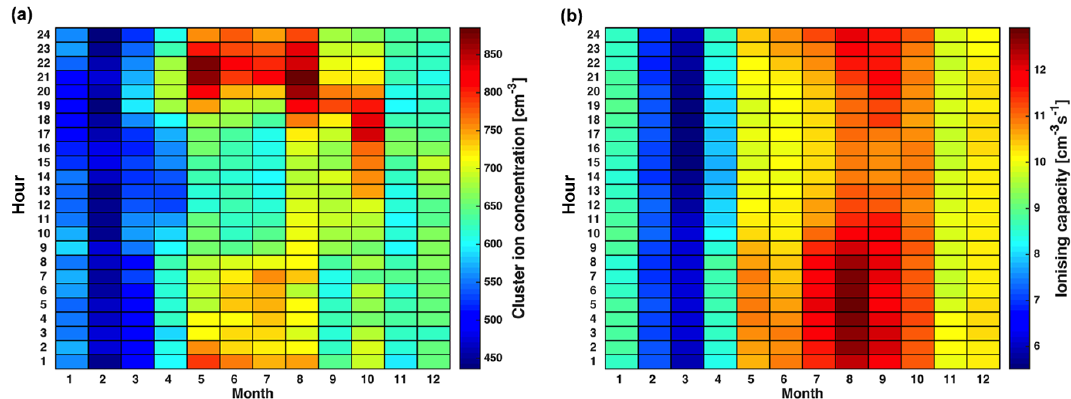
Figure 8. Median variations in (a) the mean cluster (0.8–1.7nm) ion concentrations of negative and positive polarities measured by a balanced scanning mobility analyser (BSMA) and (b) the total ionising capacity over the years 2003–2006. Hourly medians were calculated for the whole measurement period from the 10min measurement data prior to the processing of median values for each month as a vector of hour-of-day.